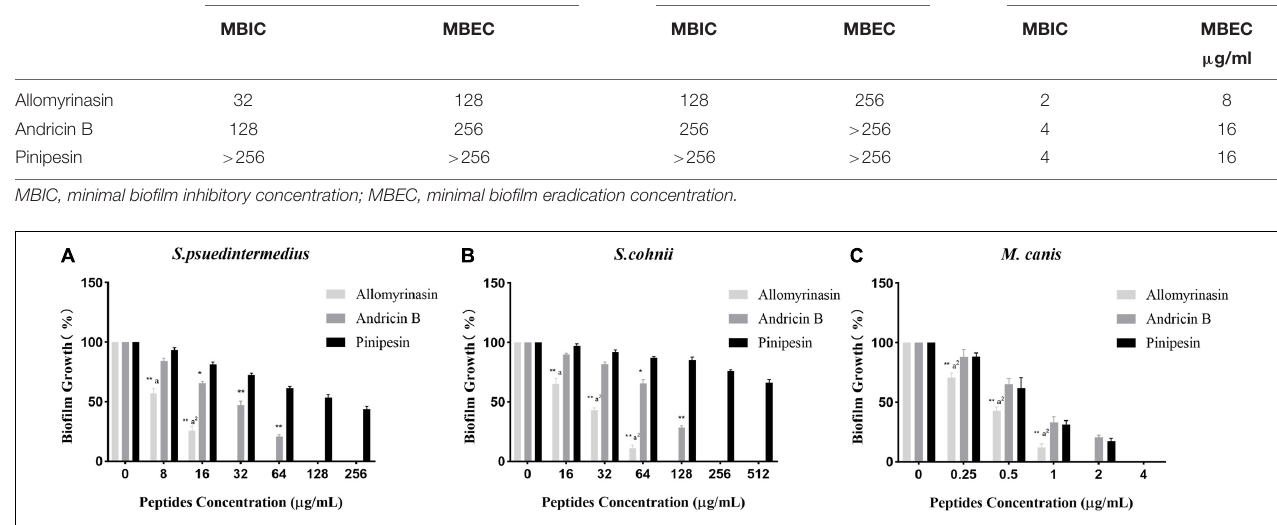
TABLE 2 | The effects of allomyrinasin, andricin B, and pinipesin on mature biofilms and their formation by Staphylococcus pseudintermedius MW767056, Staphylococcus cohnii MW767053, and Microsporum canis MW768151. Peptides